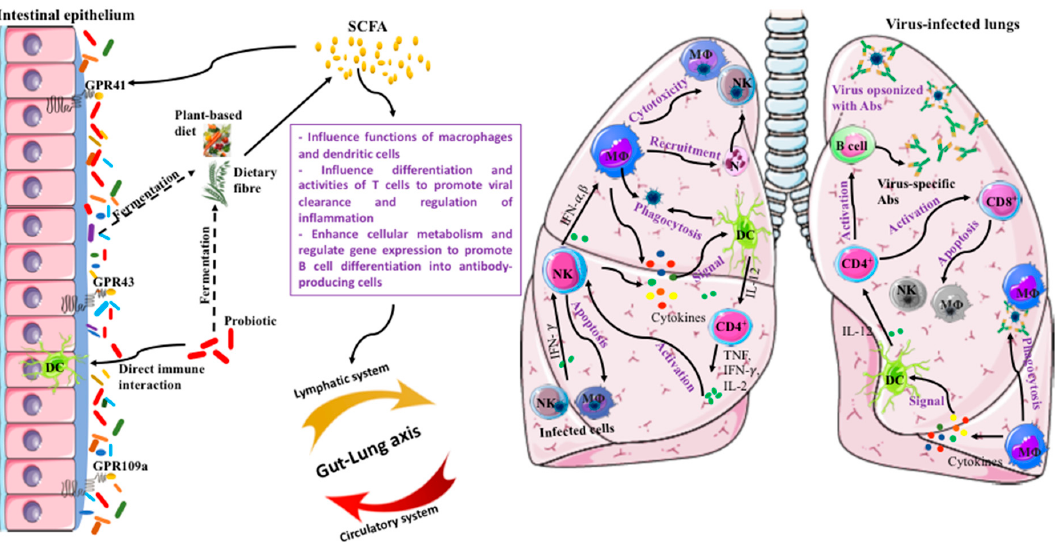
Figure 2. Potential mechanism by which synergistic synbiotic-induced short-chain fatty acids (SCFAs) can regulate the innate and acquired immune responses to attenuate viral respiratory infection.